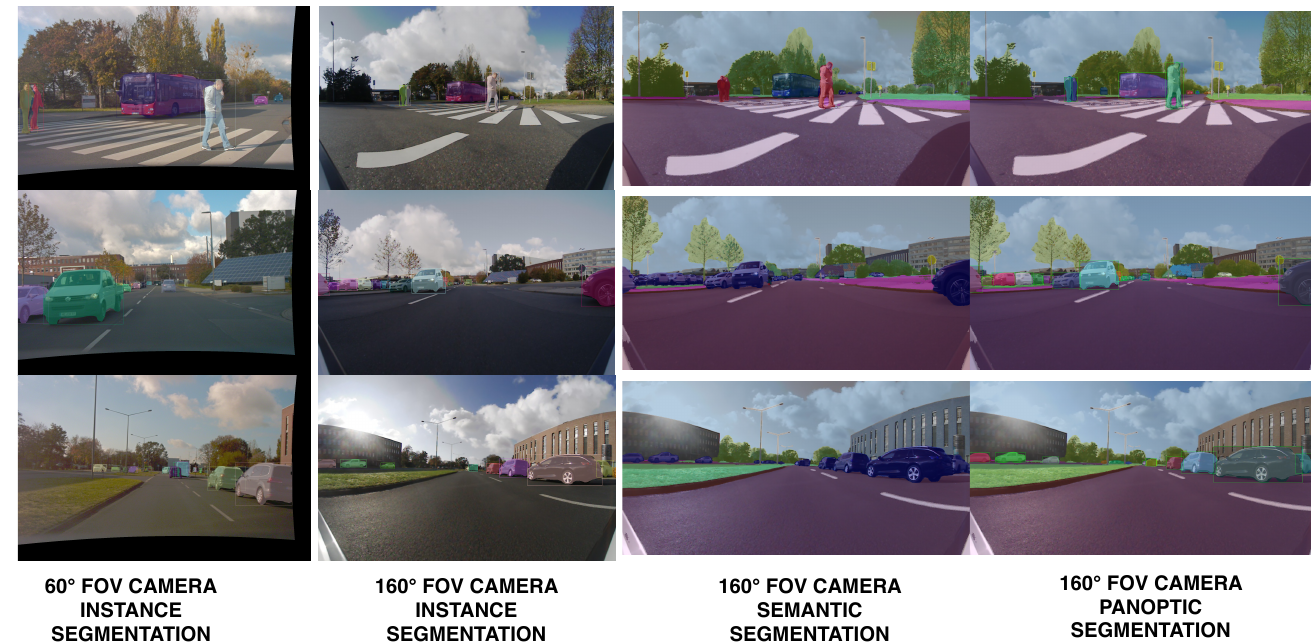
Figure 6. Comparison of the front narrow FoV and the front area-view instance segmentation. The apparent sizes of objects is larger in the 60 ◦ FoV image than the area-view image. By introducing the narrow FoV image, we increase the instance segmentation depth range. We provide instance, semantic and panoptic segmentation on the front area-view